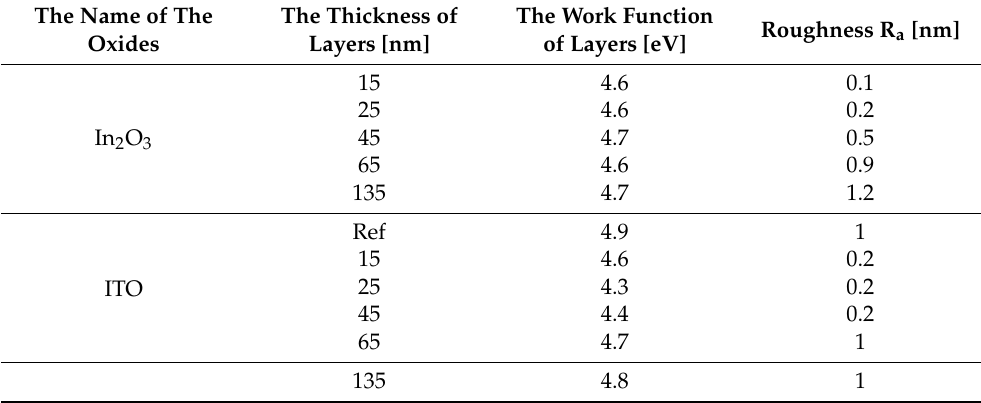
Table 4. The results of the work function, thickness, and roughness of the investigated samples